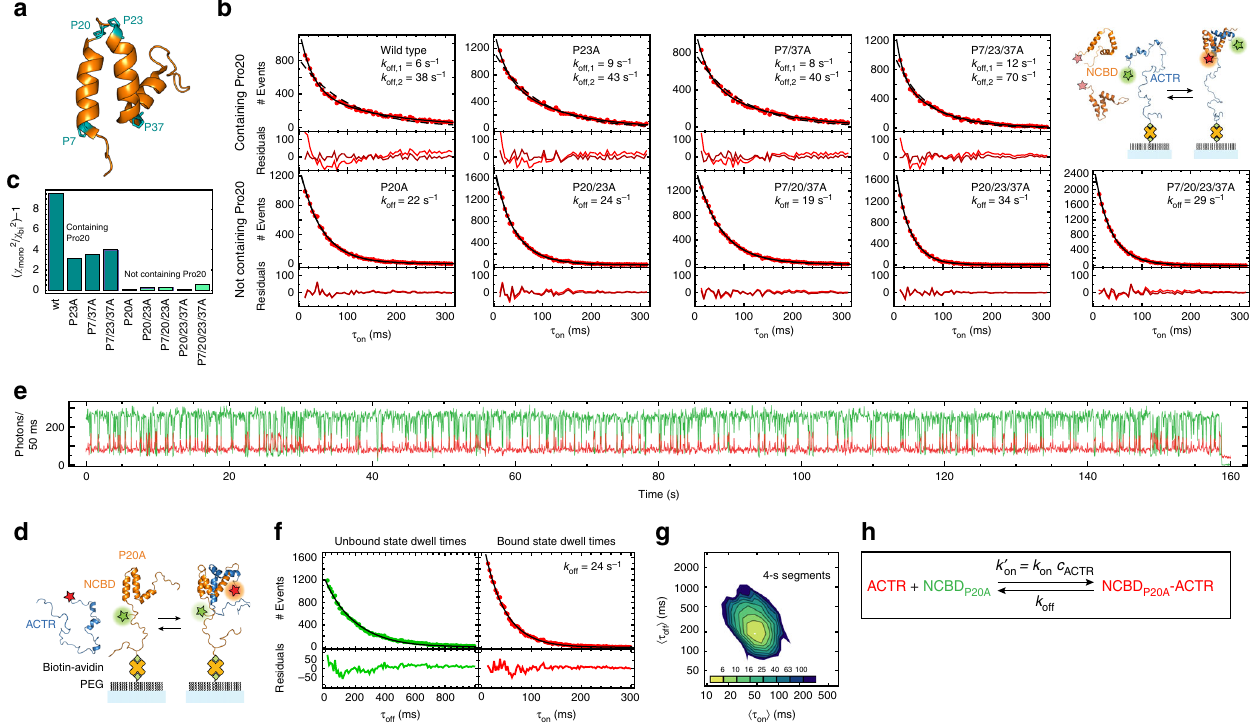
Fig. 3 Isomerization of Pro20 is the cause of kinetic heterogeneity. a Model of NCBD (PDB entry 2KKJ) 23 , with helix-terminating proline residues highlighted in turquoise. b Dwell-time distributions for the bound state of surface-immobilized ACTR for all NCBD variants, with single-exponential (dashed line, light red residuals) and double-exponential fi ts (solid line, dark red residuals) and the fi tted rates indicated. Dwell times below 12 ms are too short to be identi fi ed reliably by the Viterbi algorithm (Supplementary Fig. 6) and are hence omitted. MLH analysis results are compiled in Supplementary Table 2. c Normalized ratio of chi-squared as an indicator for the quality of single- and double-exponential fi ts in b , showing variants containing Pro20 in dark green and those with Pro20 exchanged by Ala in light green. d Schematic representation of acceptor-labeled ACTR (blue) binding to surface-immobilized donor- labeled NCBD P20A (orange). e Corresponding representative single-molecule time trace (donor emission green, acceptor emission red). f Dwell-time distributions and residuals for ACTR binding to and dissociating from surface-immobilized NCBD P20A, with single-exponential fi ts (solid lines). g 2D histogram of 〈 τ on 〉 and 〈 τ off 〉 from 113 time traces showing a single kinetic cluster. h Two-state kinetic model used to analyze the time traces of NCBD